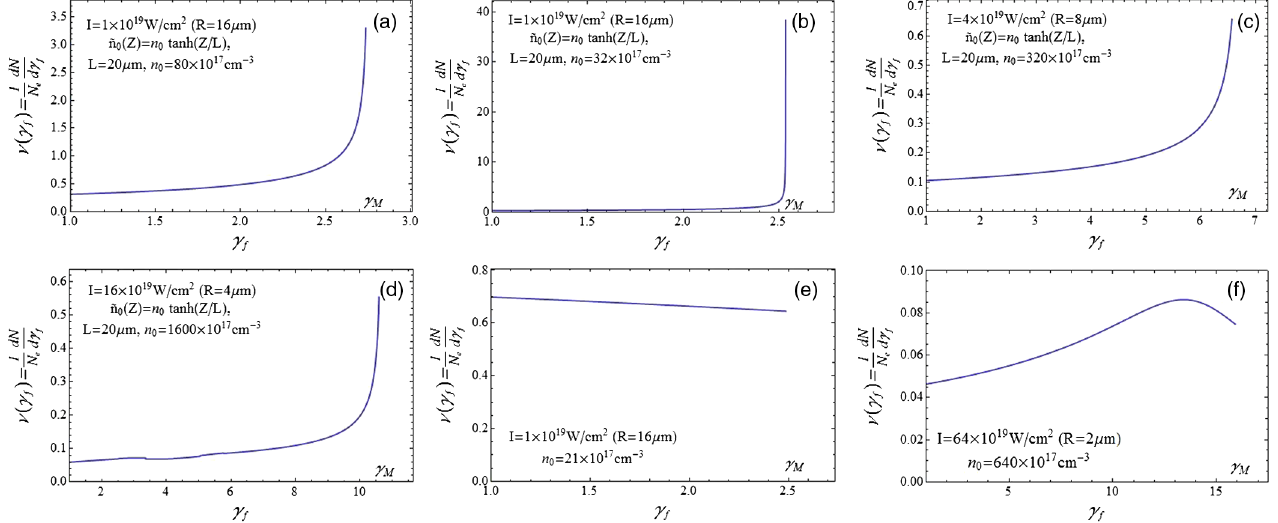
FIG. 10. Sample spectra of the expelled electrons for pulse amplitudes of the form (40) with continuous initial electron densities e n ≡ n θ ð Z Þ tanh ð Z=L Þ , L ¼ 20 μ m (graphs a-d), or step-shaped initial electron densities e n 0 ð Z Þ 0 n 0 and of the average pulse intensity I are the same as in Table I.